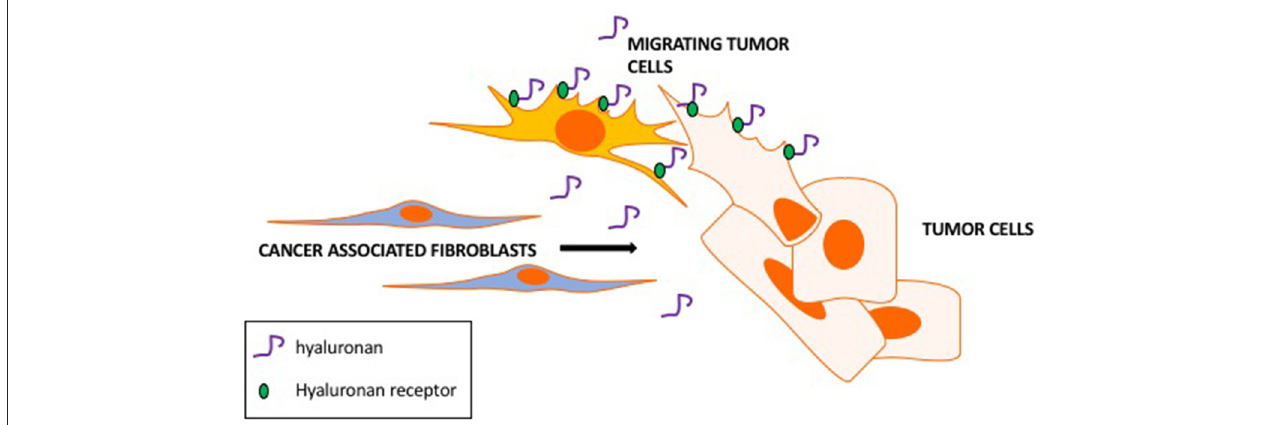
FIGURE 5 | Hyaluronan promotes CAFs motility toward tumor cells and tumor cell motility. CAF subsets produce hyaluronan as a motogenic stimulus for migrating toward tumor cells. Hyaluronan binds to tumor cell subsets via hyaluronan receptors (RHAMM and CD44) contributing to the migration and invasion of CAF-guided tumor